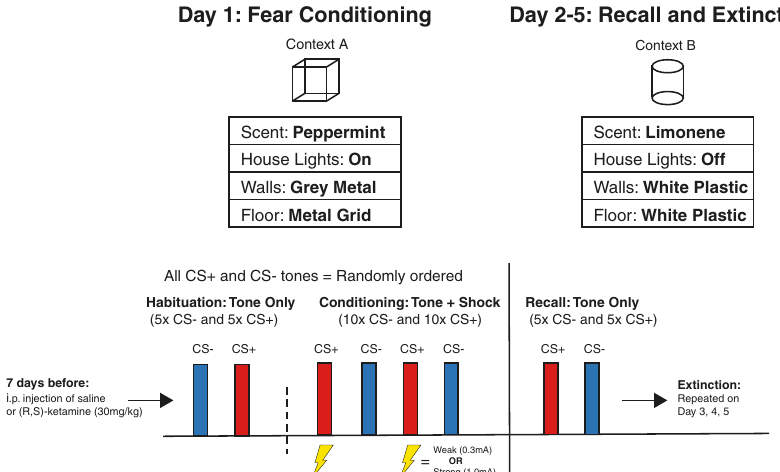
Fig. 1 Schematic of fear conditioning and recall behavioral protocol. One week prior to testing, mice are injected with either saline or (R,S)- ketamine (30 mg/kg). Habituation and auditory fear conditioning on Day 1 in Context A, followed by four days of re-exposure to CS + and CS − in absence of US (unconditioned stimulus, electric foot shock). Tone order (CS + or CS − ) randomly varied across testing days. Context A and Context B varied in terms of scent present in the chamber, lighting conditions, and chamber wall/ fl oor material and